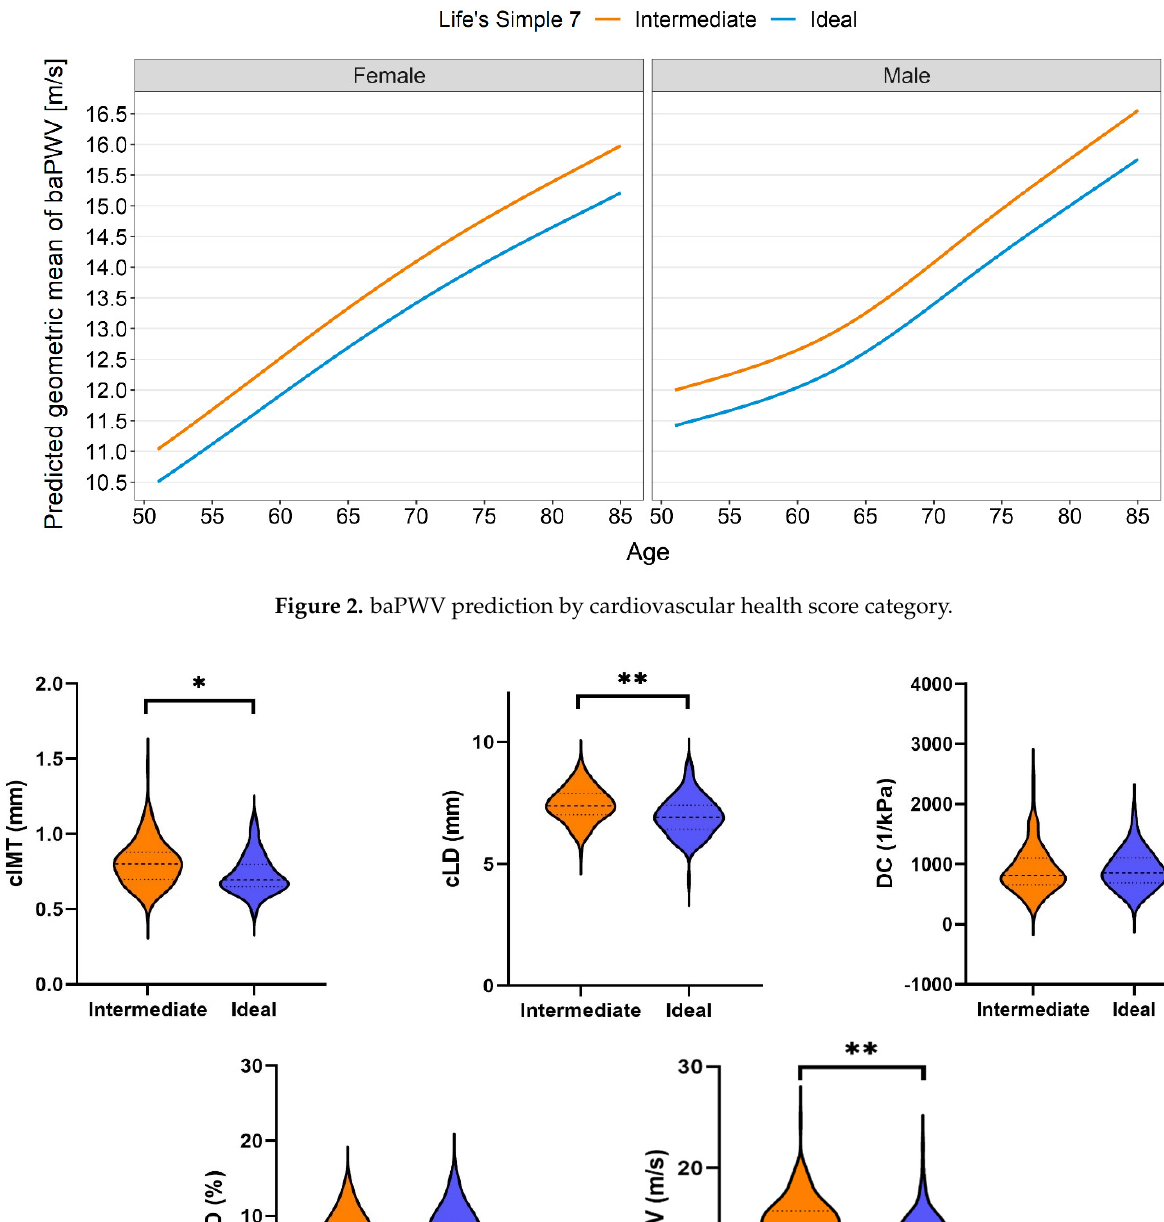
Figure 2. baPWV prediction by cardiovascular health score category. Table 2. Estimated mean difference or ratio of geometric means of the arterial properties between ideal and intermediate cardiovascular health score. Based on multiple imputation models. Adjusted for age and sex.